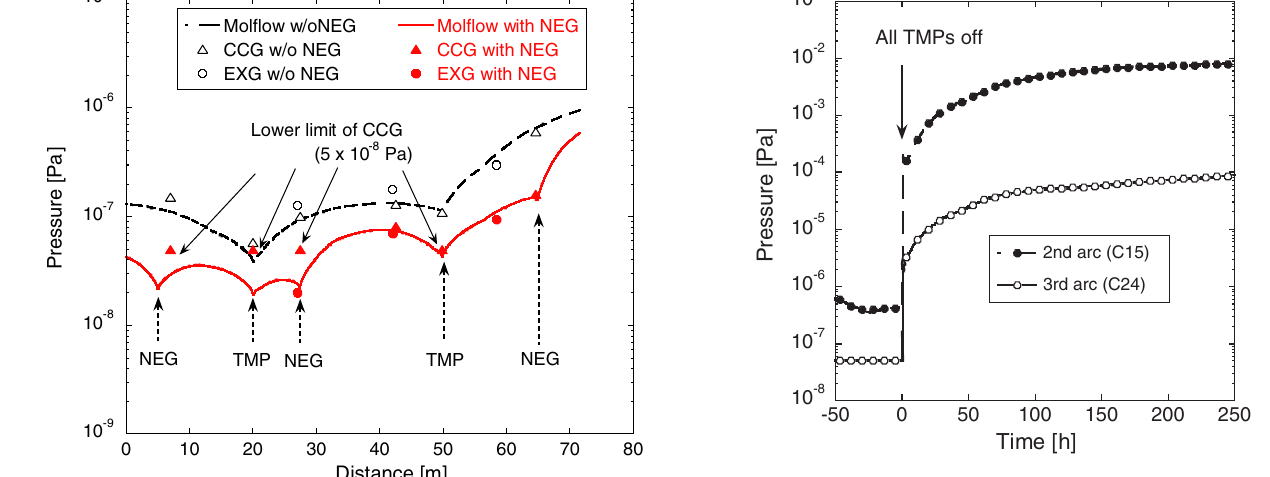
FIG. 25. Pressure distribution in the third arc section before and after the NEG pump installation. The dashed and solid lines denote the calculated pressure by M olflow+ without and with NEG pumps, respectively. The open triangles and circles represent the pressure without the NEG pumps measured by the CCGs and the EXGs, respectively. The closed triangles and circles represent those with NEG pumps. The pressure value of 5 × 10 − 8 Pa is the minimum limit of CCG